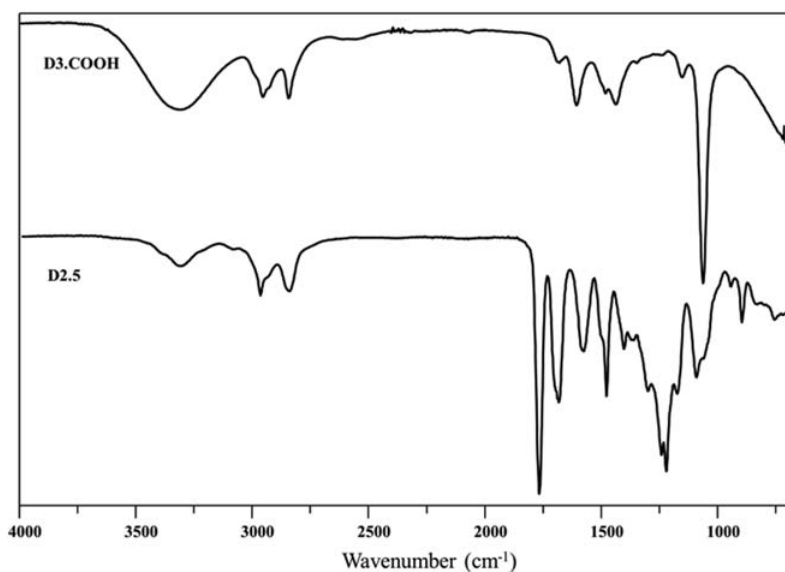
Figure 2. ATR monitoring and time dependency from ester to amide (D2.5 to